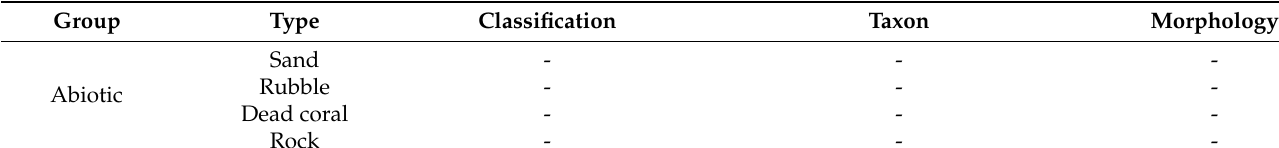
Table 1. Classification scheme of benthic habitat, and data collected in this